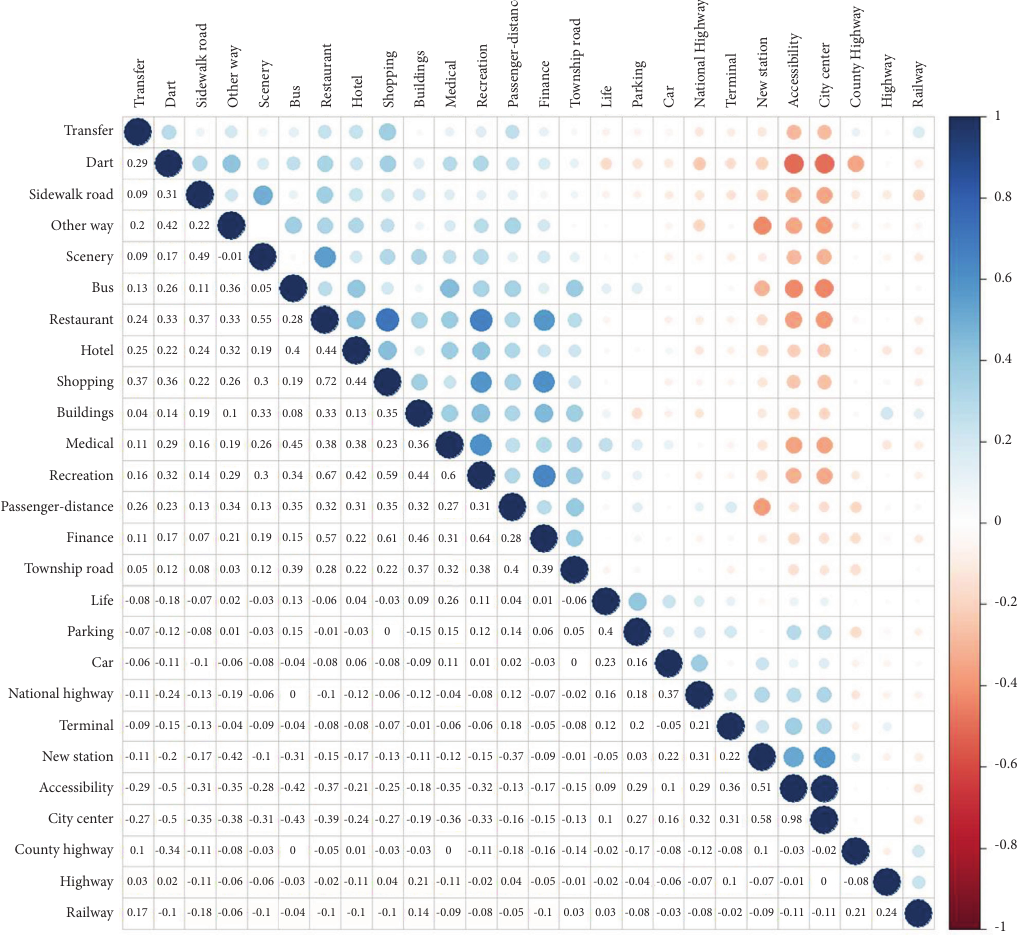
Figure 10: Pearson’s correlation coefficient matrix. Table 3: OLS model